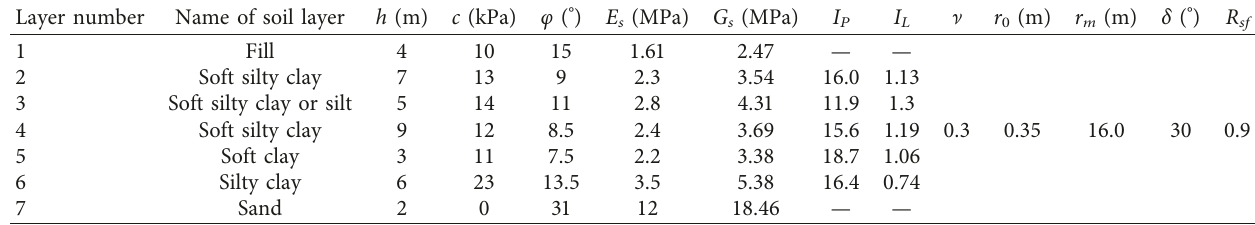
Table 4: Soil profiles and parameters of Wulin Road excavation.